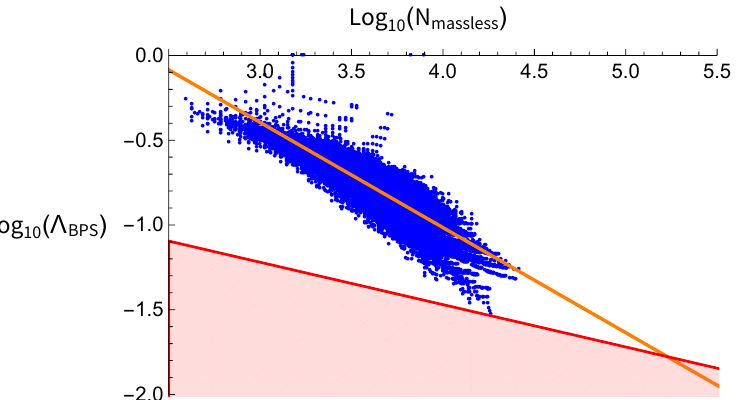
Figure 3 . Schematic plot where the toric examples are plotted on top of the restriction required by a qualitative version of the species bound, involving only massless fields. This naive expression would exclude situations where the lightest field is below the blue line, and so is not compatible with the linear trend observed in the data if this is extrapolated indefinitely, suggesting a maximum value for N . There is an uncontrolled O (1) factor in the species bound line, which manifests in this logarithmic plot as an uncontrolled offset. This is why the plot is only schematic, and we cannot make a sharp prediction for the maximal N